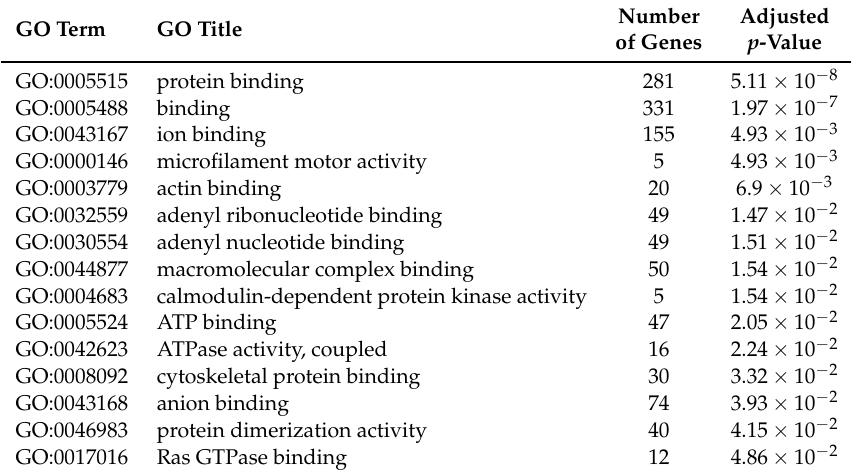
Table 1. Top 15 Gene Ontology (GO) molecular function terms based on the adjusted p -value for the eggshell strength at Time Point 1 (ESS1).